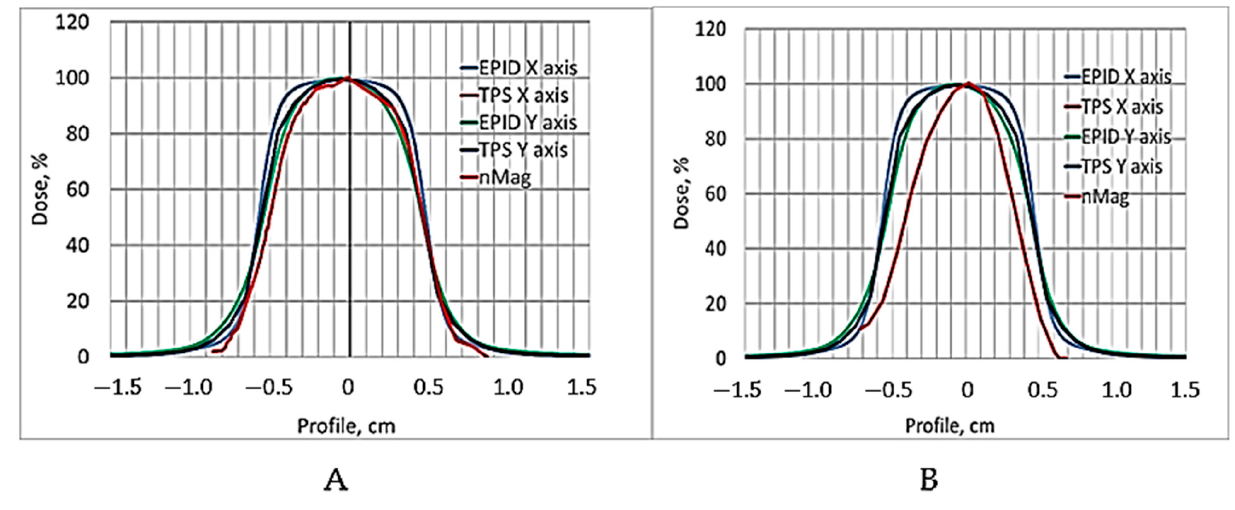
Figure 6. 12 Gy dose profiles used for comparison: ( A ) TPS, EPID and CT evaluated dose profile of irradiated nMAG gel obtained 56 h post-irradiation, ( B ) TPS, EPID and CT evaluated dose profile of irradiated nMAG gel obtained 240 h post-irradiation. Gels dose profiles are indicated in red.